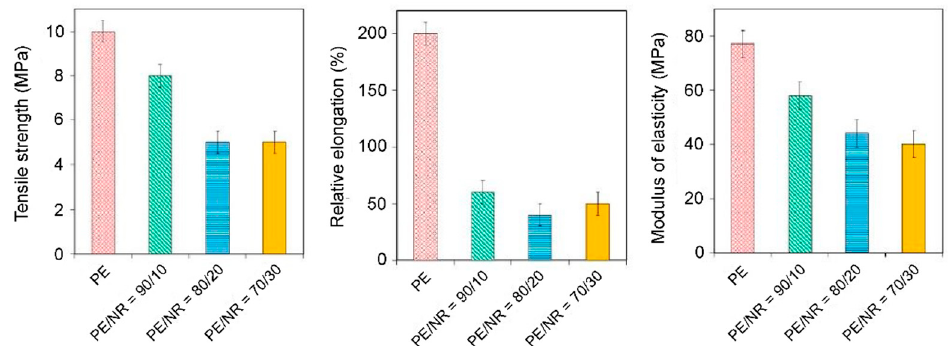
Figure 10. Parameters of ultimate strength at break, elongation at break and modulus of elasticity in tension for pure PE and PE/NR composites with NR content at level of 10, 20, 30 wt.%. Adapted from Mastalygina Elena et al. [52].